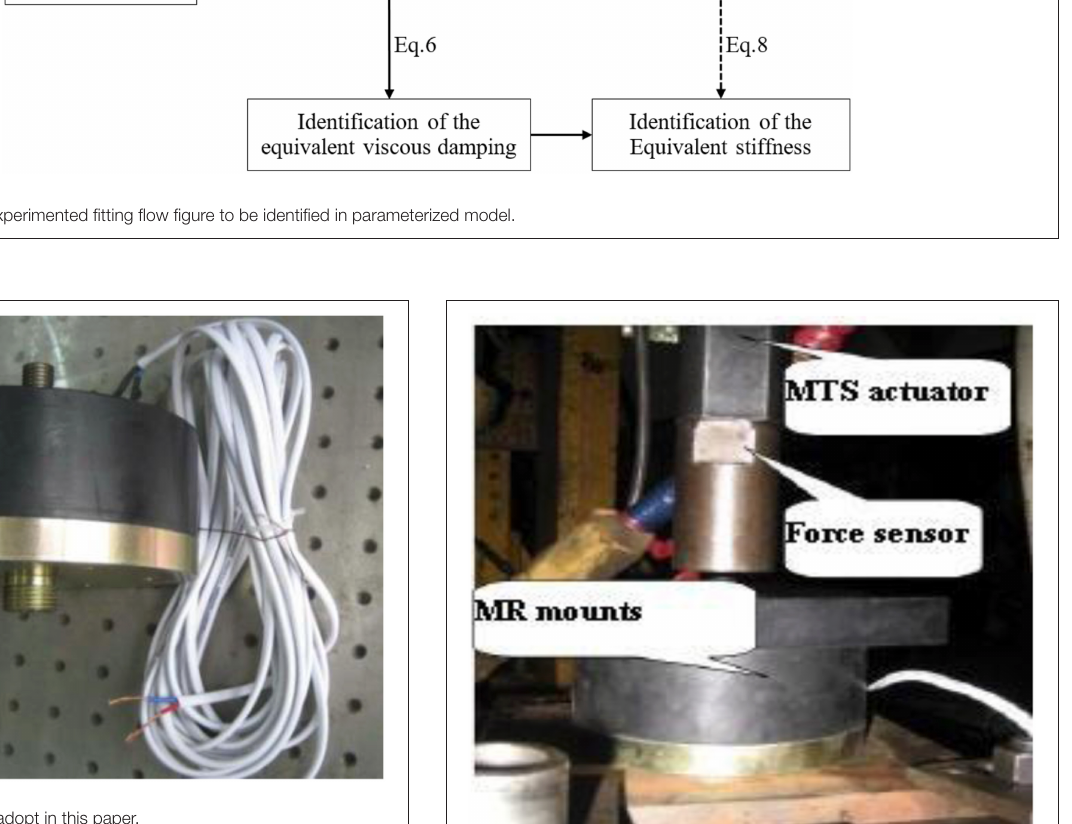
FIGURE 6 | MR mounts adopt in this paper.